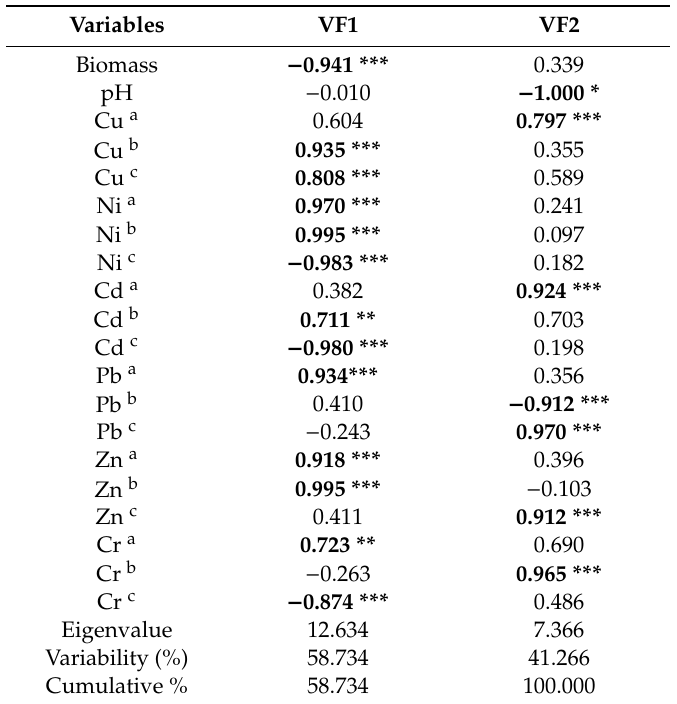
Table 3. Varimax rotated factor matrix for the analyzed dataset.